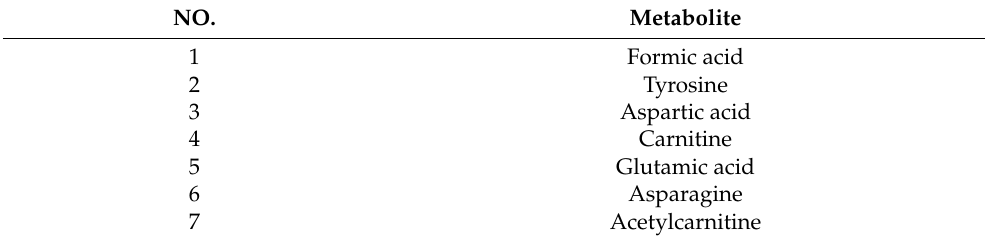
Table 5. METH-related differential metabolites.